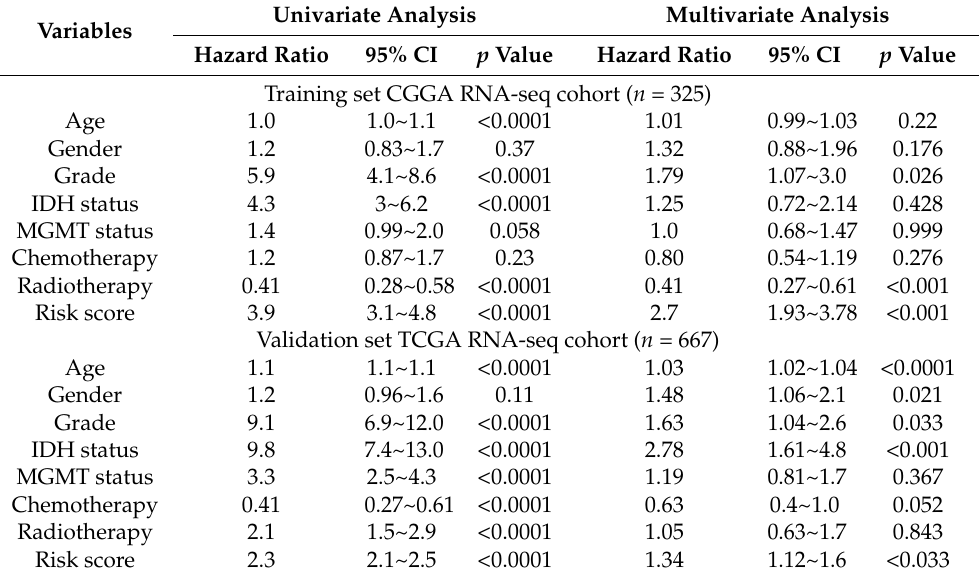
Figure 4. Prognostic value of 10-gene risk signature in CGGA and TCGA dataset. ( A , B ) Kaplan– Meier Survival curves for all grade gliomas and GBM patients in CGGA dataset. ( C , D ) Kaplan–Meier Survival curves for all grade gliomas and GBM patients in TCGA dataset. Table 2. Univariate and multivariate Cox regression analysis of the clinical features and risk score for OS in CGGA and TCGA datasets.